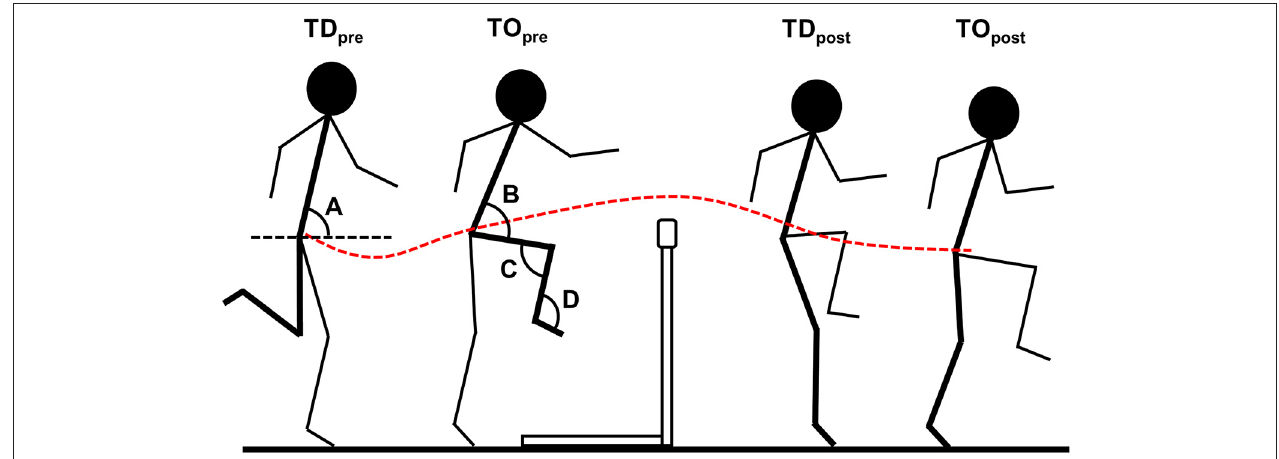
FIGURE 2 | Representative schematic of the four critical instants used in the current study (TD pre , TO pre , TD post , and TO post ). Bold segments represent segments analyzed. Angles analyzed are represented with A (trunk angle), B (hip angle), C (knee angle), and D (ankle angle). Red, dashed line represents center of mass